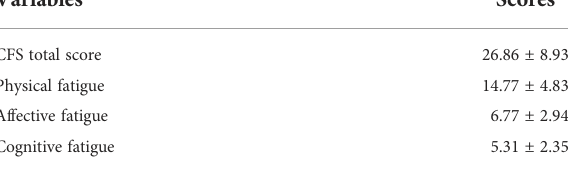
TABLE 3 Cancer Fatigue Scale scores in lung cancer patients with chemotherapy (N =